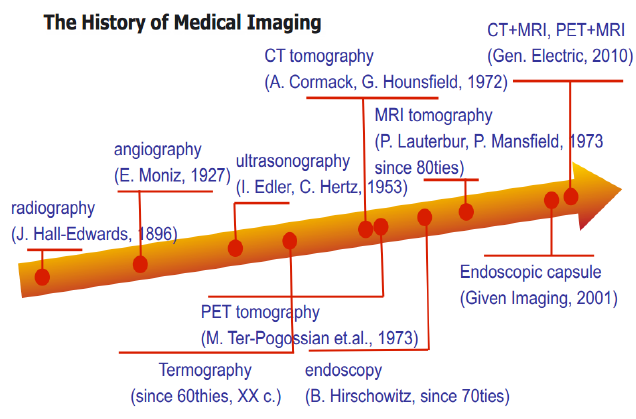
Fig. 2. The history of medical imaging [2]